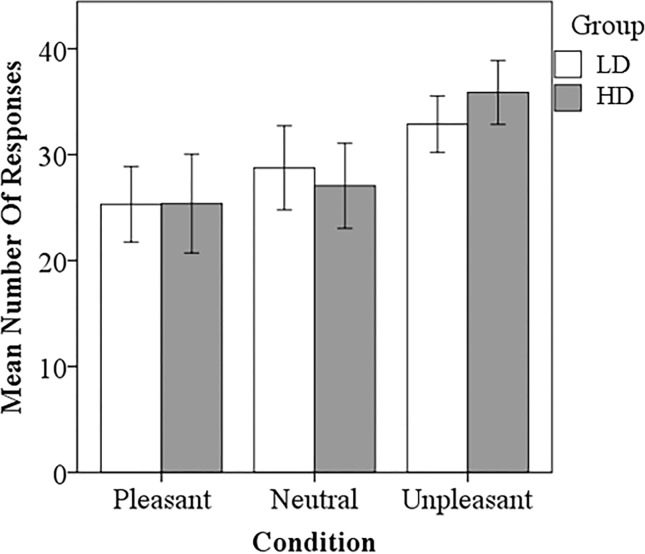
Task based rating results.No significant differences between the LD and HD group were detected. The LD group responded U significantly more than P. The HD group responded significantly more U than P and N. Statistical significance level p<0.05.